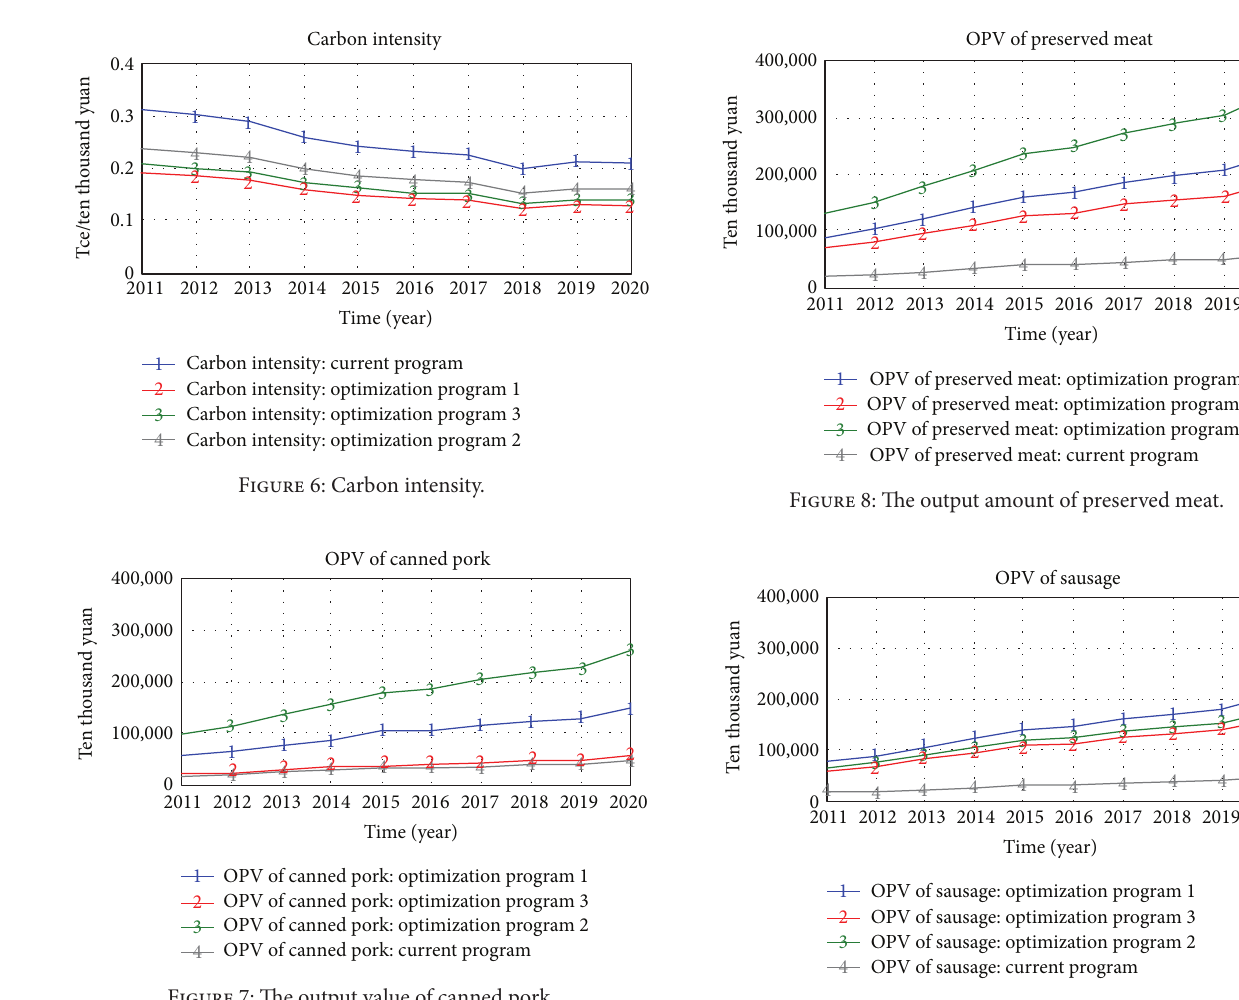
Figure 9: The output value of